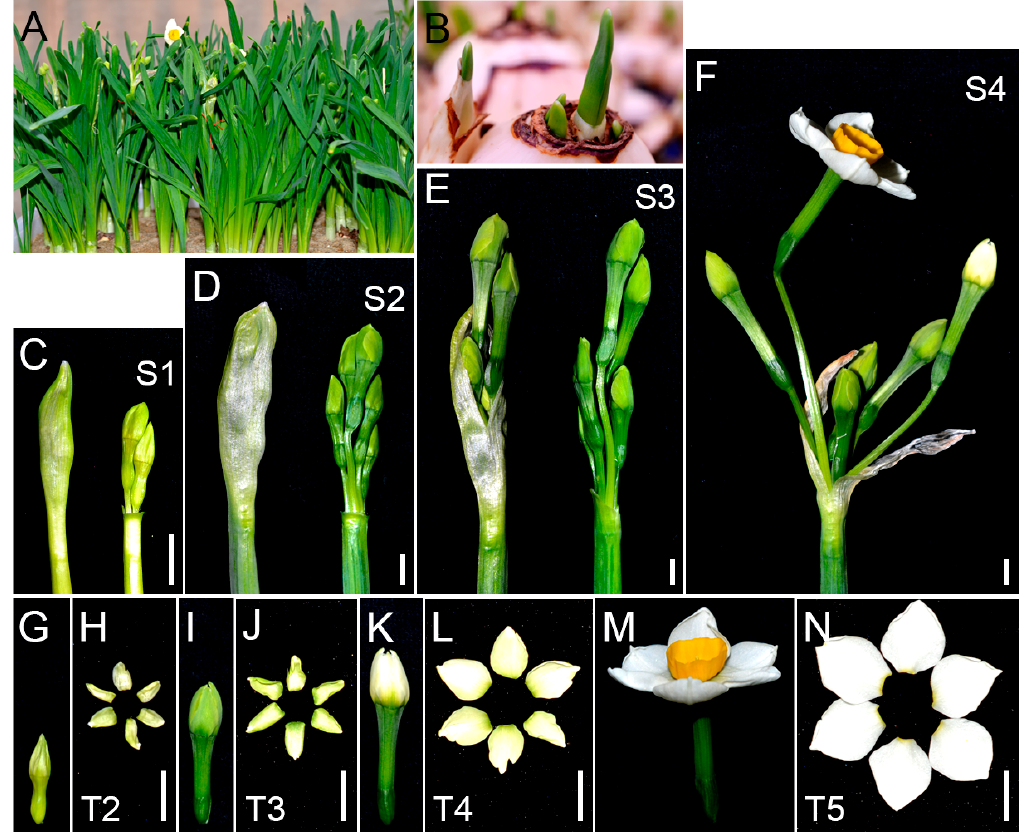
Figure 1. Flower development and tepal pigmentation characteristics of Chinese narcissus cultivated variety “Jinzhanyintai”. ( A ) An overview of flower development of “Jinzhanyintai” after cultivated for 20 days in greenhouse. The sheathed leaves are robust and some flowers are opening; ( B ) Shoots with sheathed leaves come out from bulbs after planting for five days. This is the first time point for collecting tepals for RNA-seq (S1,T2); ( C , G , H ) Spathe with wrapped umbel (flower buds) was isolated from cultured bulbs five days after planting. The whole spathe and flower buds were completely embedded in shoots and displayed faint-yellow color ( C , G ); Tepals (T2) were collected and used for RNA-seq and metabolites analysis ( H ); ( D , I , J ) Spathe with wrapped umbel (flower buds) was isolated from bulbs 10 days after planting. Unopened spathes with wrapped umbel have emerged out from bulbs and turned deep-green ( D , I ); This was the second time point for collecting tepals for RNA-seq and metabolites analysis (S2,T3) ( J ); ( E ) New splited spathe with deep-green umbel (flower buds) isolated from bulbs 16 days after planting. The color of tepals at this time point (S3) was the same as in tepals at S2; ( F ) Umbel with opening flower and flower buds close to open after planting for 19 days. The color of tepals at this time point (S4) will gradually fade, turn from deep-green to green/white, and at last turn into pure white in opening flowers; ( K , L ) Green-to-white transition buds ( K ) and tepals ( L ). Tepals at this stage (T4) were collected and used for RNA-seq and metabolites analysis; ( M , N ) Opening Chinese narcissus flower ( M ) and its pure white tepals ( N ). Tepals at this stage (T5) were collected for RNA-seq and metabolites analysis. Bar = 1 cm.